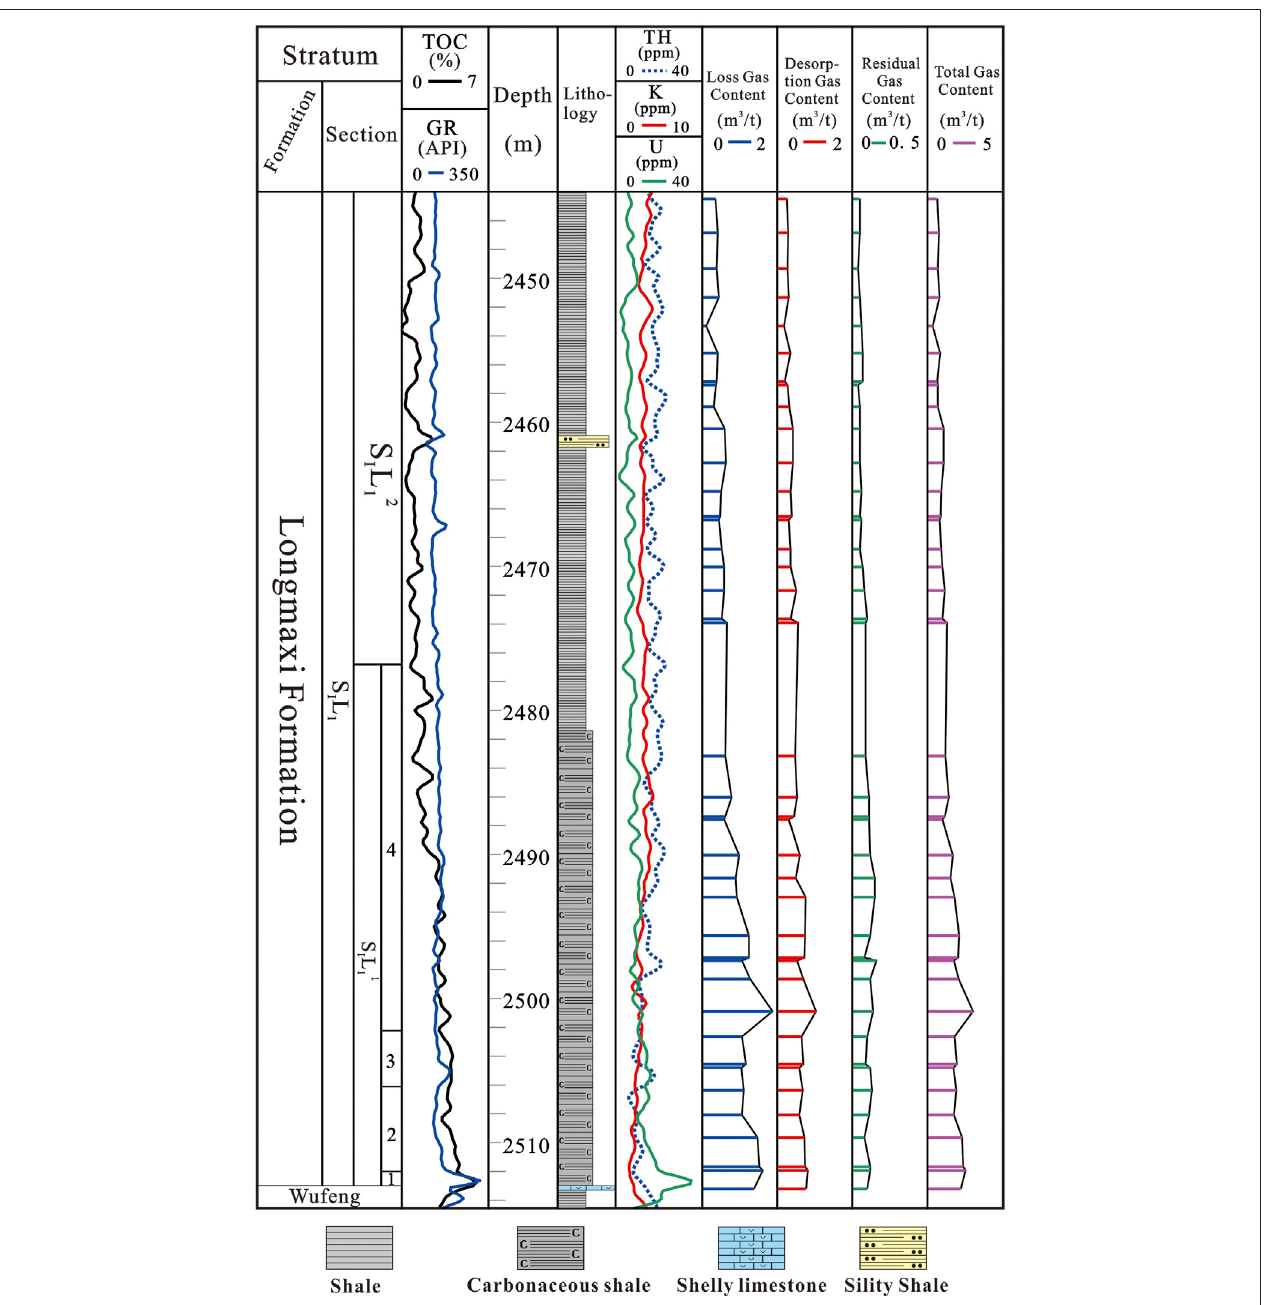
FIGURE 3 | The total gas content, residual gas content, desorbed gas content, and lost gas content of the Longmaxi Formation in X15 well, see Figure 1 for the well location.